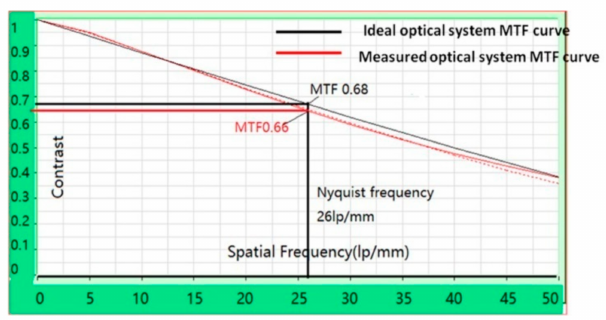
Figure 11. Measurement graph of MTF vs. frequency.